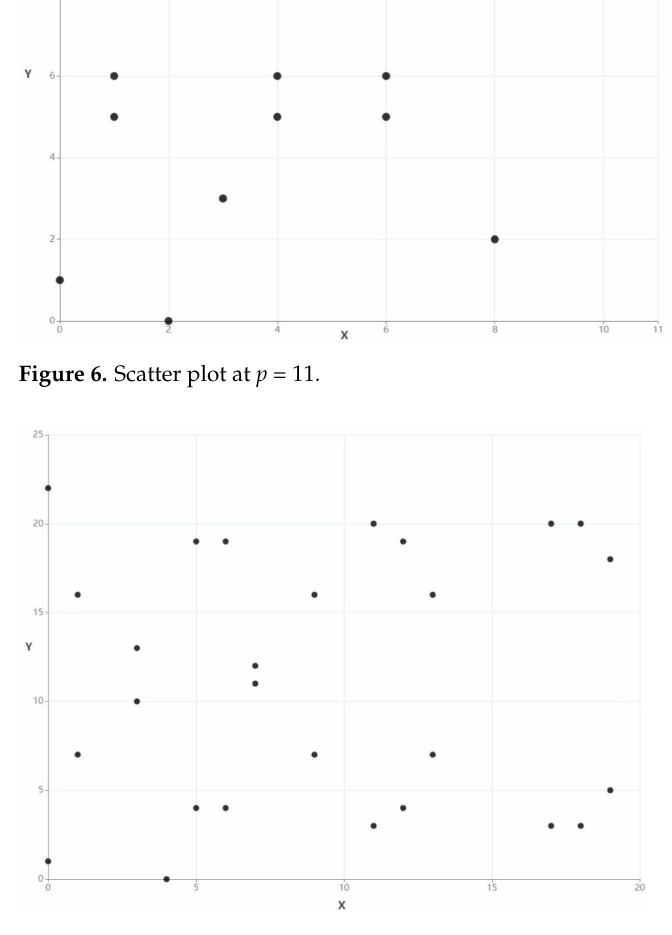
Figure 7. Scatter plot at p = 23. Table 1. Required key length for the same decryption time